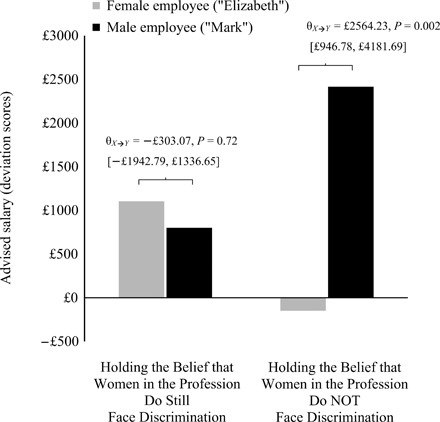
Managers’ advised salary for the target employee, by the purported gender of the employee and managers’ beliefs about whether women in their profession still face discrimination (n = 229).To account for individual differences in base salary rates, managers reported the typical salary in their practice for employees with similar experience as the target, and this was subtracted from the advised salary; thus, any differences in base salary rates (can be substantial across different regions of the country) were accounted for by analyzing respondent-specific deviations in advised salary. Y-axis values therefore represent deviations in advised salary (from individually adjusted base salary). A value of £0 indicates that managers advised paying the target employee the same as others in their practice with comparable experience. Among managers who believe discrimination against women is no longer an issue, they advised that the male employee receive a higher salary than the otherwise identical female employee. Analyses probed the interaction (by managers’ beliefs) at ±1 SD. These values correspond to a general endorsement/rejection of these beliefs. For ease of interpretation and because the values represent categorically distinct beliefs, they are presented as bars (estimated means at ±1 SD with covariates at their sample means). The differences in means correspond to the following values: “Holding the Belief that Women in the Profession Do Still Face Discrimination,” θX➔Y = −£303.07, SE = £832.00, P = 0.72 [−£1942.79, £1336.65]; “Holding the Belief that Women in the Profession Do NOT Face Discrimination,” θX➔Y = £2564.23, SE = £820.71, P = 0.002 [£946.78, £4181.69]. For an analogous depiction with the above confidence intervals (around the conditional effect of target gender, θX➔Y | M), see fig. S3.